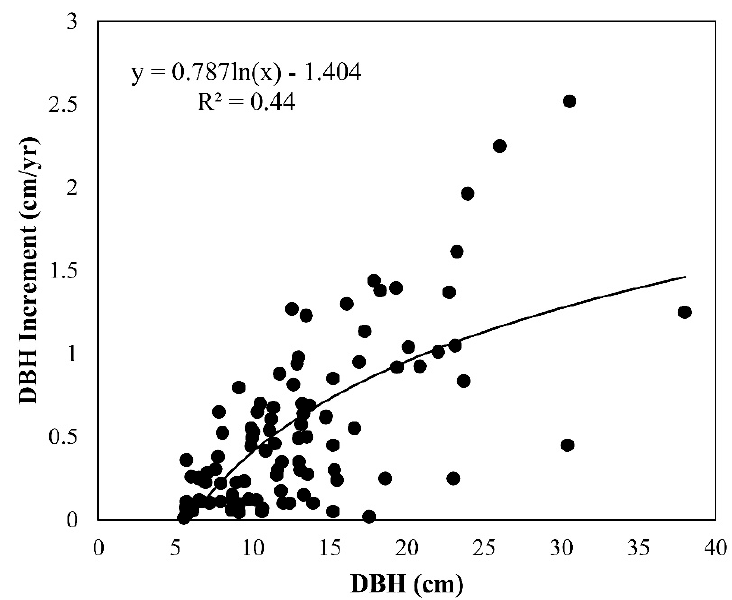
Figure 2. Relationship between DBH and annual DBH increment at tree level in Sabah ( n = 347). Compared to the plot-level approach in [37], considerable variations in DBH increment can be observed at tree level, but the annual rate is clearly dependent on the tree DBH. Table 2. Regression Statistics of the Height Estimation